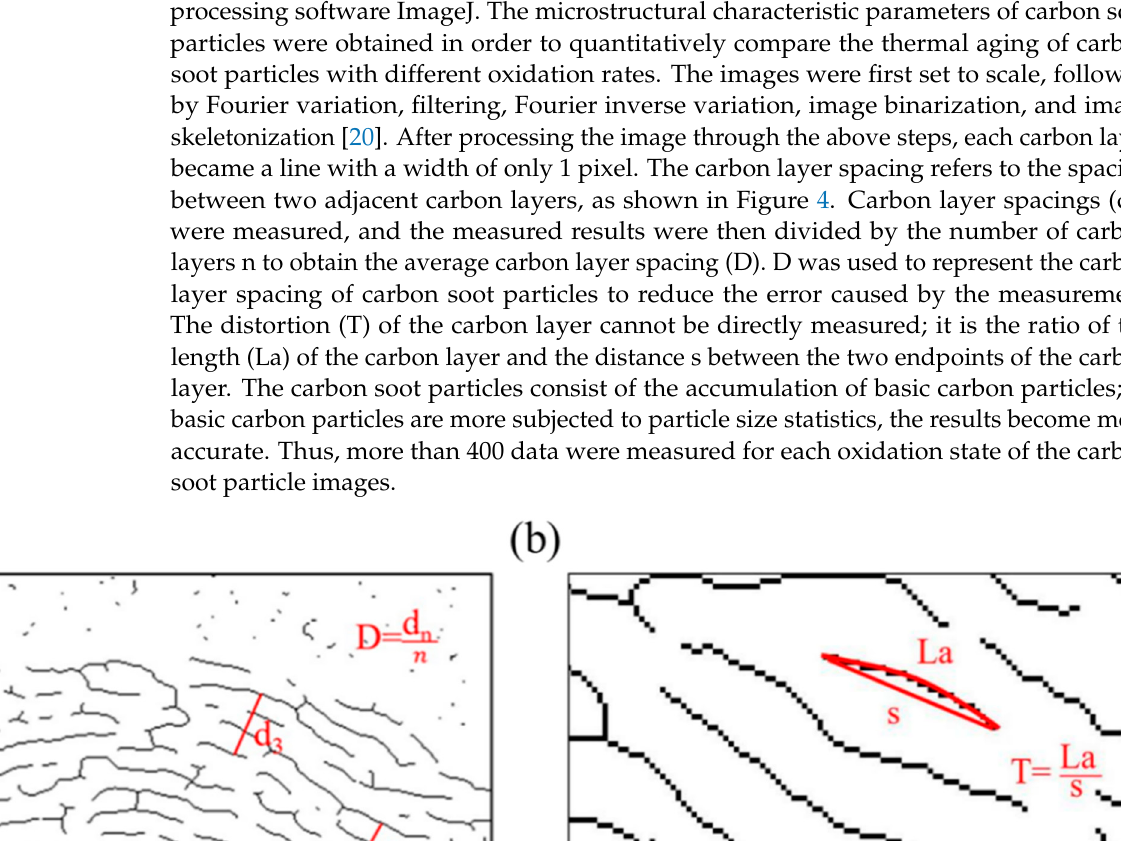
Figure 3. “Cross method” measurement method.